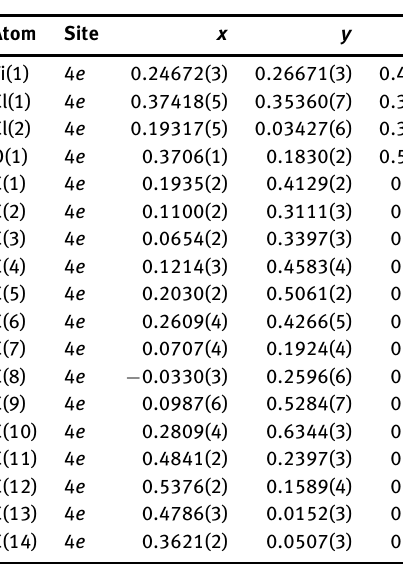
Table 3: Fractional atomic coordinates and displacement parameters (Å 2